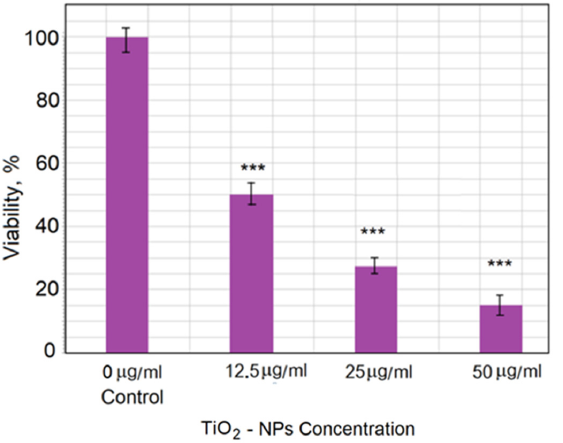
Figure 12. Viability of CHO cells after treatment with TiO 2 -NPs at different concentrations. The data are expressed as the mean ± standard error (SE) from three independent experiments. Statistical analysis was performed using Student’s t -test (*** p < 0.005). All data for TiO 2 -NP treatment were statistically significantly different from the control ( p < 0.005) (marks are not displayed in the histogram), as well as between 12.5 µg/mL TiO 2 -NP and 50.0 µg/mL TiO 2 -NP treatments ( p < 0.005).